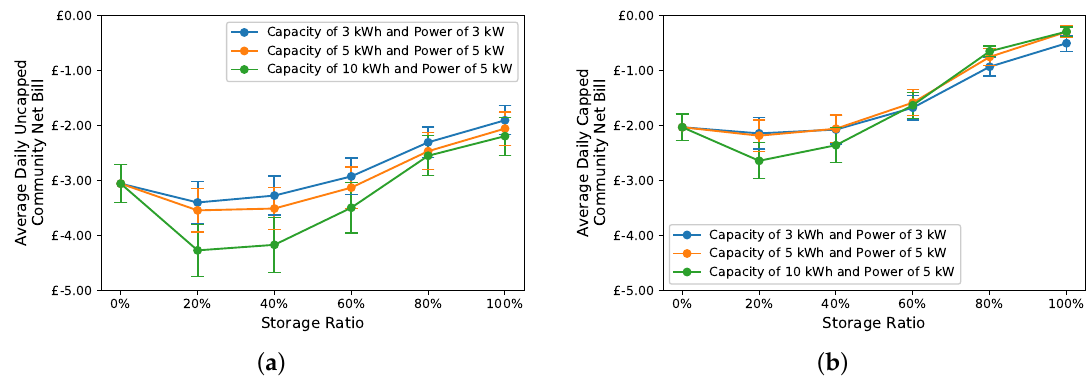
and B C for the setting with imperfect predictions Figure 11. Comparison between the average daily (cid:99) B C K K with storage. The error bars represent 95% confidence intervals. ( a ) Average daily B C . Under the K uncapped approach, increasing the storage capacity or the ratio of prosumers with storage decreases the average daily surplus, but it is still significant with around £2 per day when all prosumers have storage. ( b ) Average daily (cid:99) B C . Under the capped approach, increasing the storage capacity or the ratio K of prosumers with storage decreases the average daily surplus, but it reaches close to zero with 100% prosumers with storage. However, (cid:99) B C does not enter a deficit K